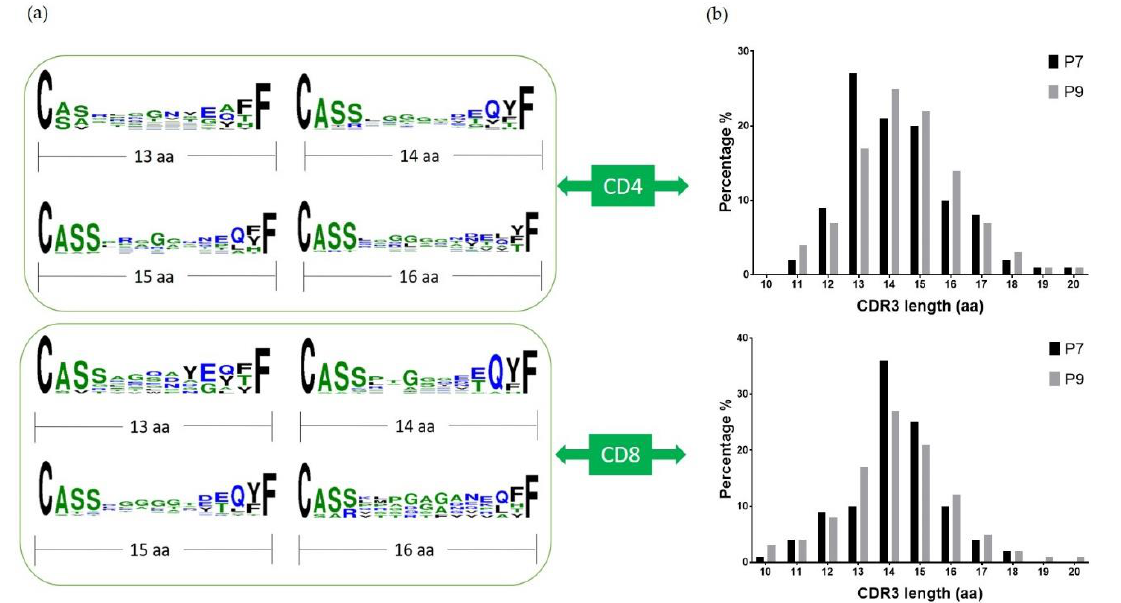
Figure 5. CDR3β sequence alignment and length comparison: ( a ) shows the alignment of CDR3β sequences from P7 and P9 T cells combined using Weblogo; ( b ) shows the distribution of the CDR3β length of P7 and P9 T cells, respectively, in CD4+ (top) and CD8+ (bottom) T cells. The x -axis is the length from amino acid C to F, and the y -axis is the percentage.